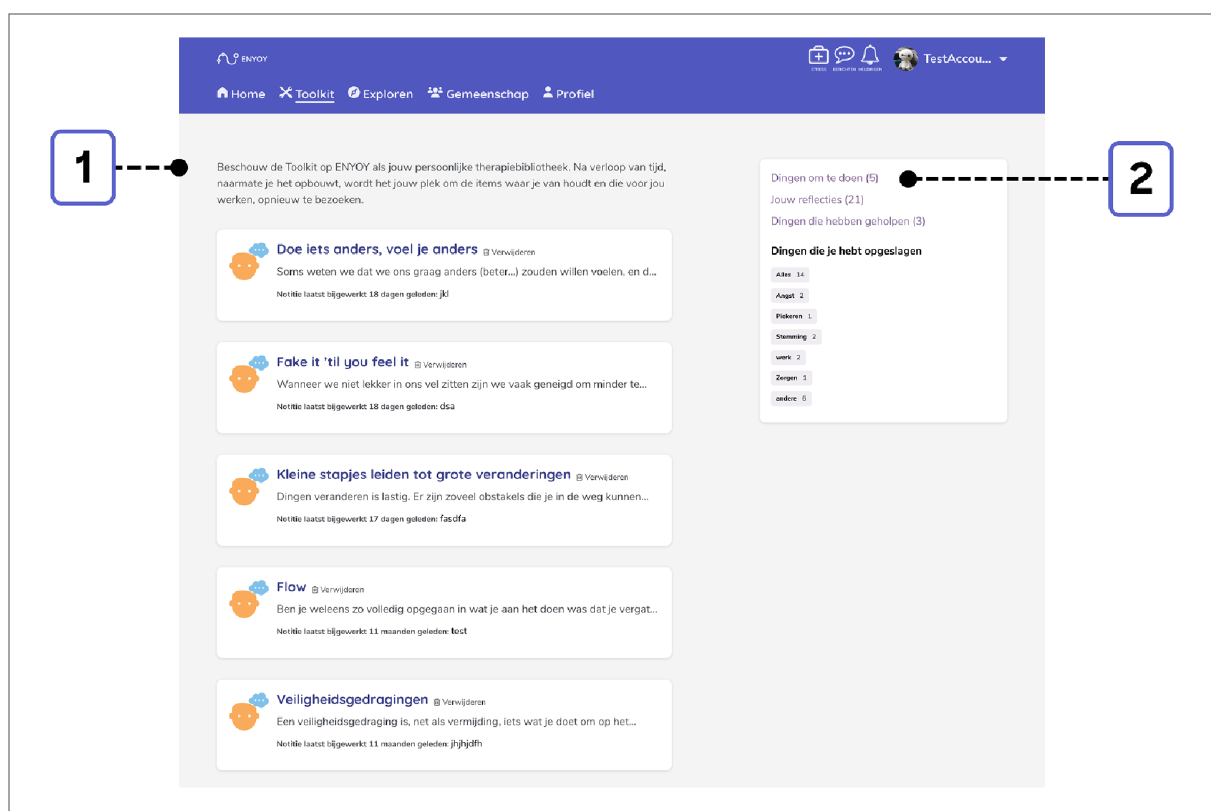
FIGURE 4 Exemplary toolkit. 1=Overview of saved exercises. 2=Saved exercises with personalized labels (e.g. anxiety, rumination,